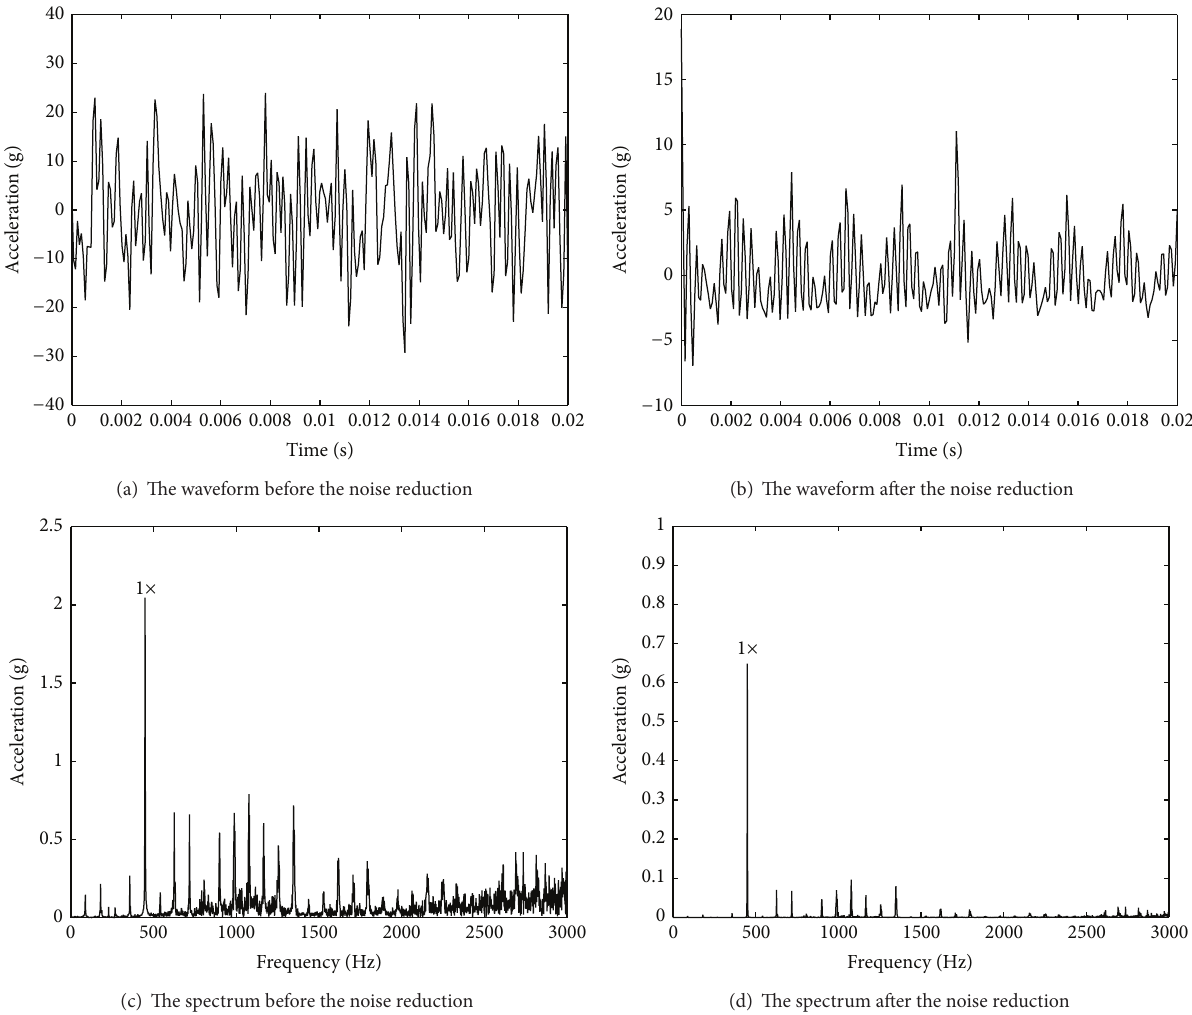
Figure 20: The time domain waveform and frequency spectrum before and after the noise reduction when rotating speed is 27000 rpm.